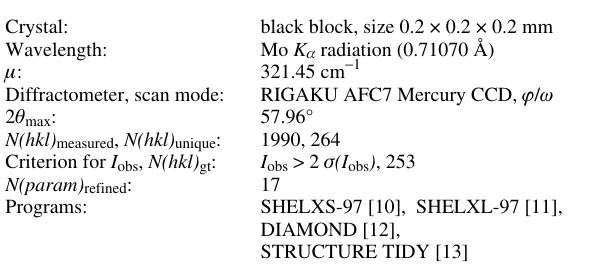
Table 1. Data collection and